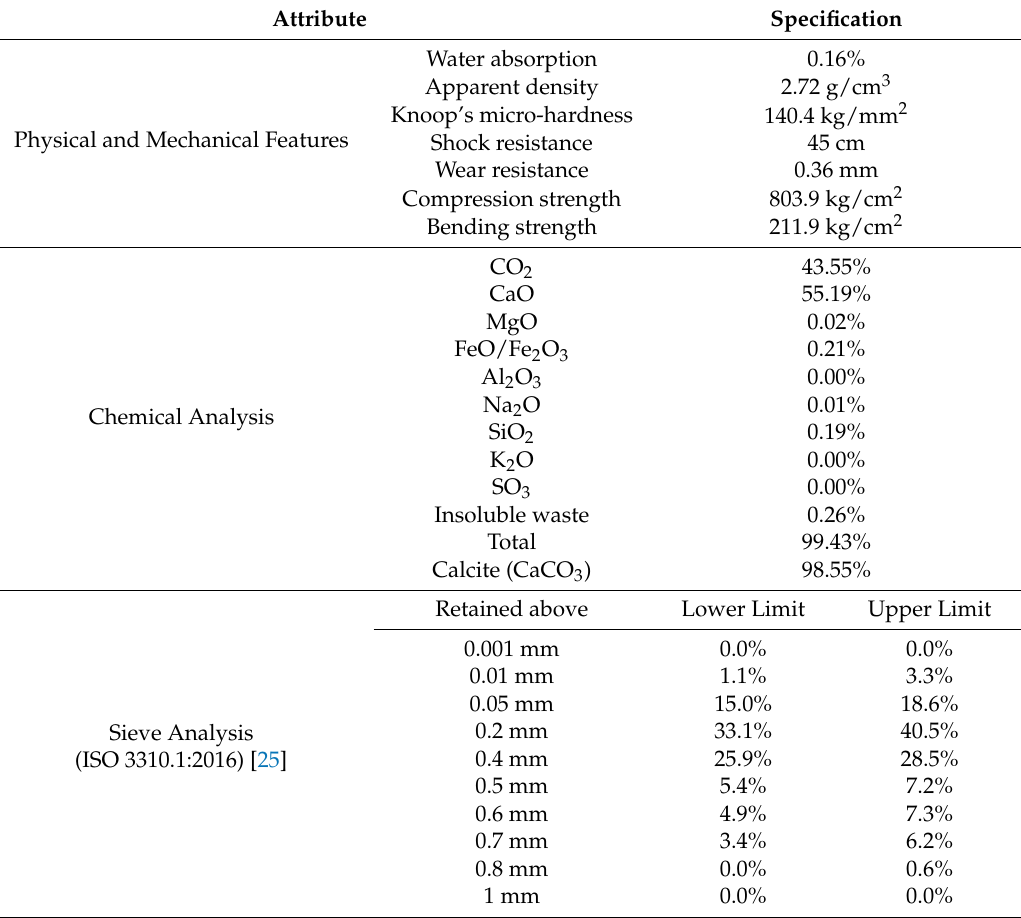
Table 9. Macael 400 white marble sand